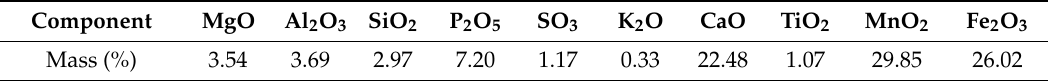
Table 2. Mineralogical Analysis of the Manganese Nodule.